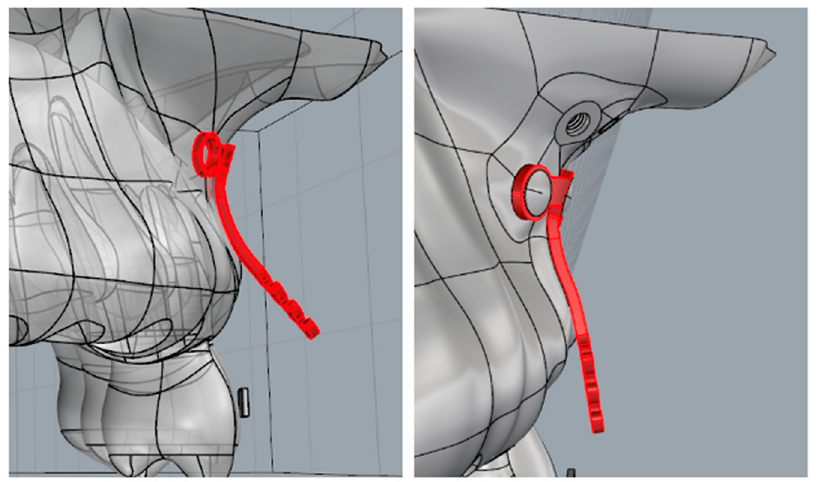
Figure 2. Position of the miniplate in the model.